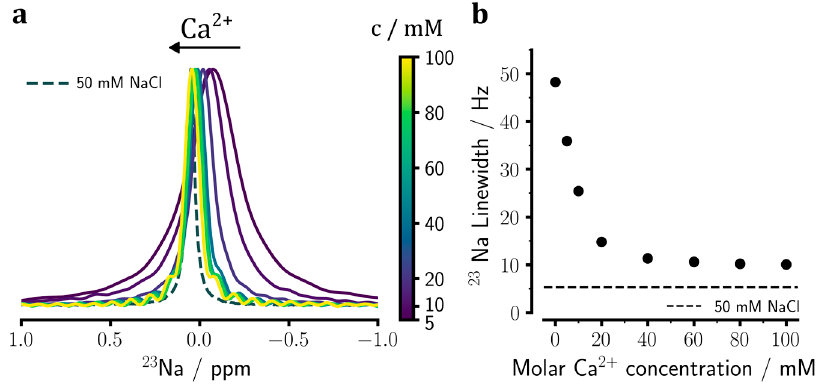
Figure 2. 23 Na NMR spectral changes of sodium heparin caused by the addition of Ca 2+ ions and the consequent release of sodium ions from heparin. ( a ) Upon titration of sodium heparin with 0 to 100 mM CaCl 2 , the 23 Na chemical shift gets narrower and moves downfield towards the chemical shift of the reference NaCl sample (see Figure 1). ( b ) Changes in the 23 Na signal linewidth in dependence of added Ca 2+ ion concentration, showing a monotonic decrease approaching a value slightly larger than the linewidth of the reference NaCl sample (represented by the dashed line). The spectra shown in ( a ) are re-scaled according to their peak intensities. The error bars in ( b ) are comparable in size to the symbols and, therefore, barely visible.